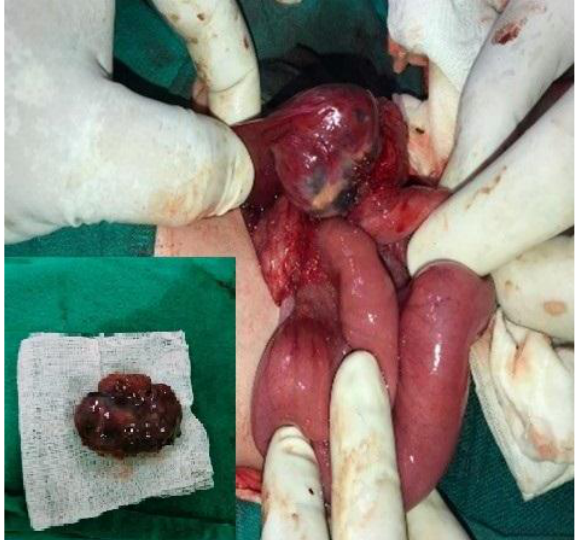
Figure 2: Liver mass with adherent small bowel. Inset shows resected lesion. The initial postoperative course remained uneventful however the baby developed wound infection and be- came septic. Antibiotics were upgraded along with wound management. The cultures of the wound and blood did not yield any organism. The patient re- sponded well and discharged on the 12th